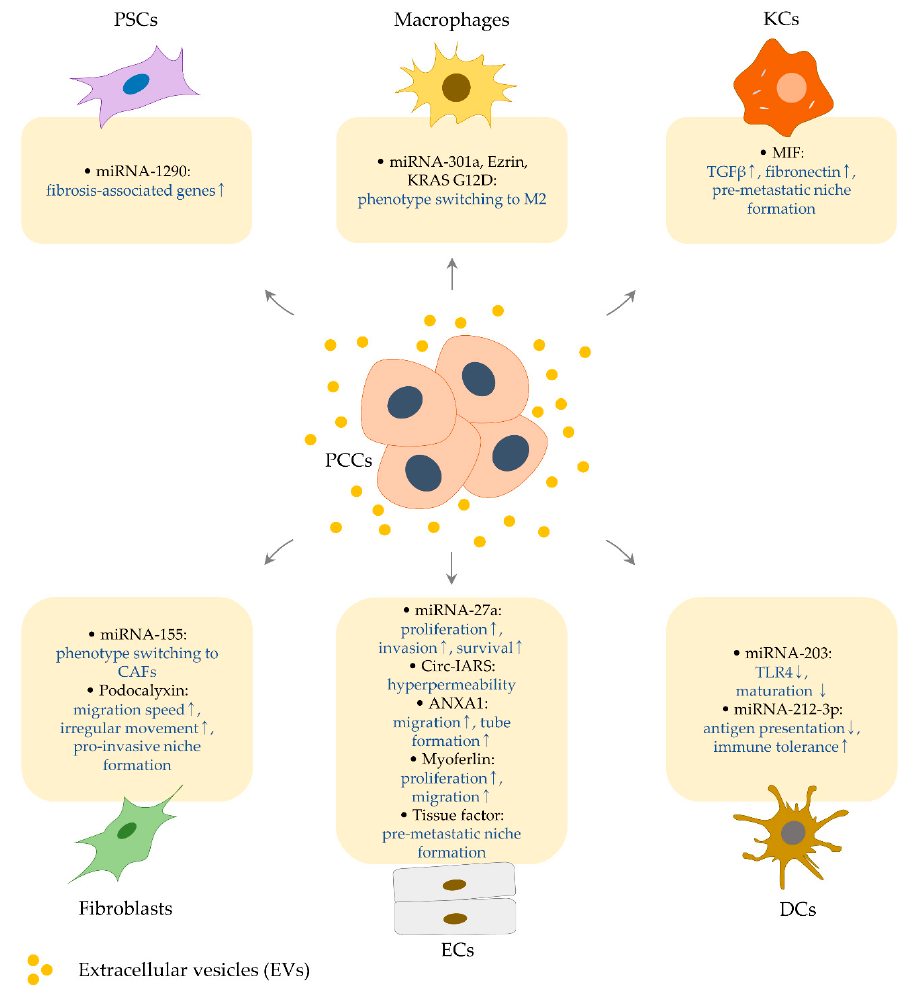
Figure 2. Effects of PCC-derived EVs and their cargo molecules on the other types of cells. Extracellular vesicles from pancreatic cancer cells retain various cargo molecules (indicated by black letters in rounded rectangles), controlling the biologic properties of adjacent or distant cells (indicated by blue letters in rounded rectangles). It is described in Section 3 and Table 2.